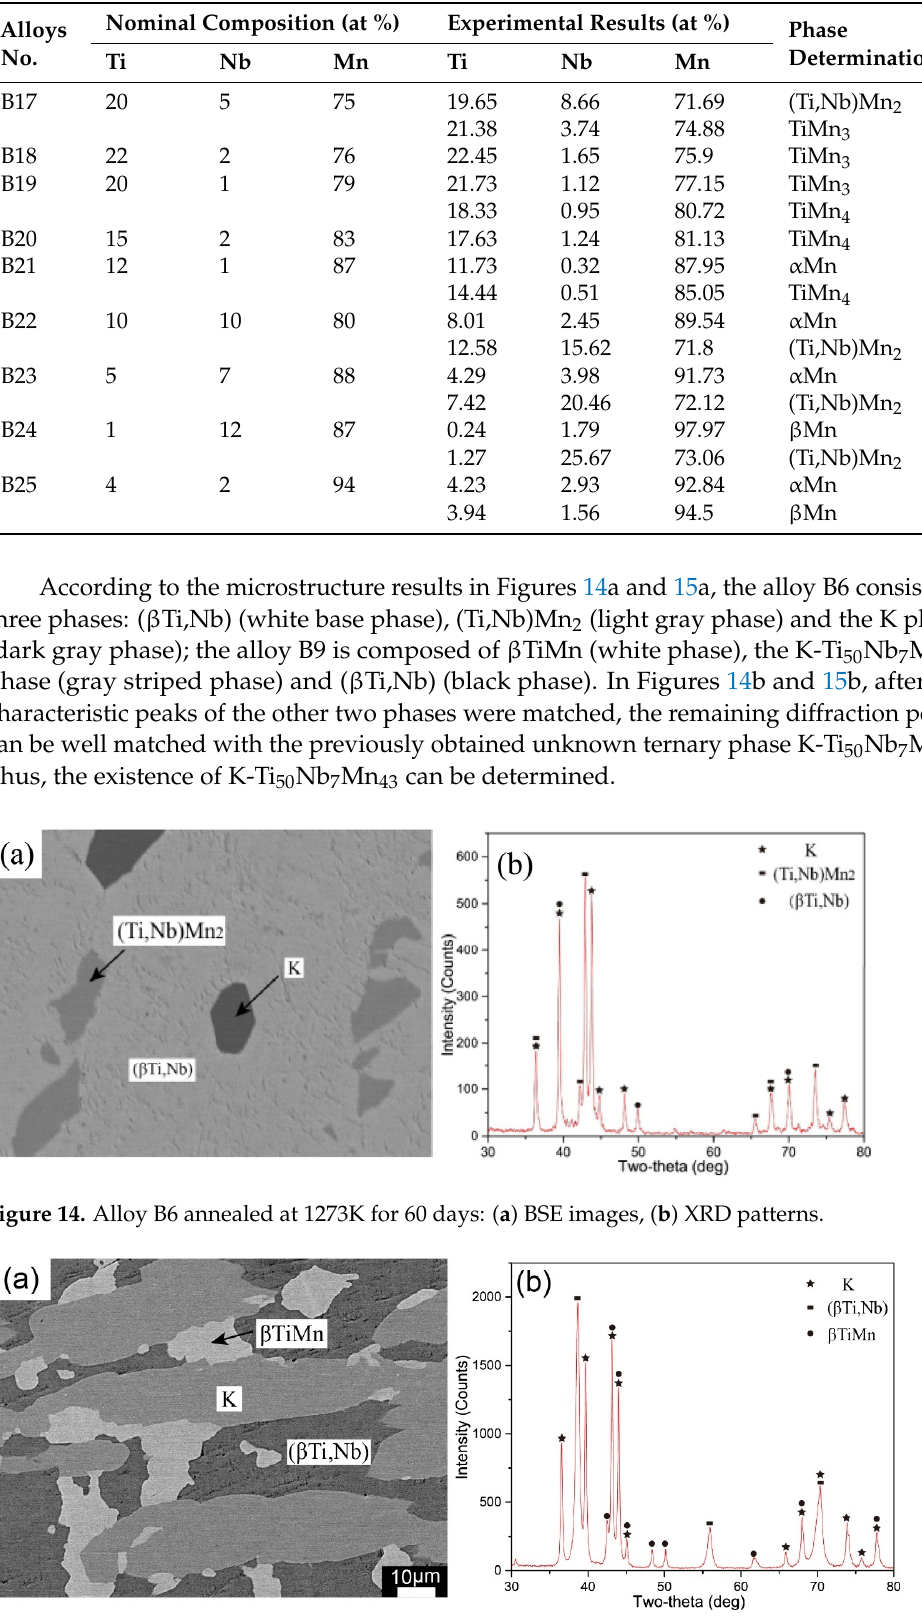
Figure 15. Alloy B9 annealed at 1273K for 60 days: ( a ) BSE images, ( b ) XRD patterns.